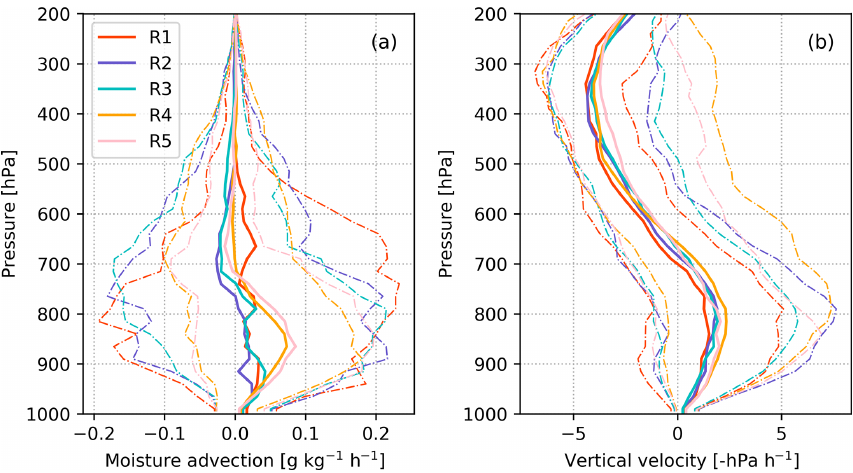
Figure 8. Median profiles (thick solid lines) of (a) horizontal moisture advection and (b) large-scale background vertical velocity (positive values signify upward motion) for each regime at 12:00UTC. The 10th and 90th percentile ranges for the variational analysis fields are represented by the dashed–dotted lines.